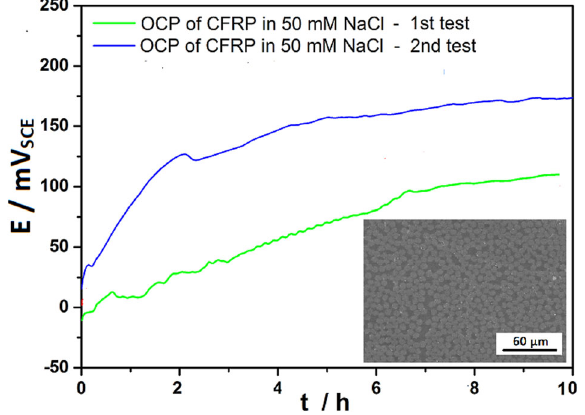
Fig. 2 Open circuit potential of CFRP. Open circuit potential pro fi le for CFRP in 50 mM NaCl (inset is a low magni fi cation SEM image of CFRP surface prior to